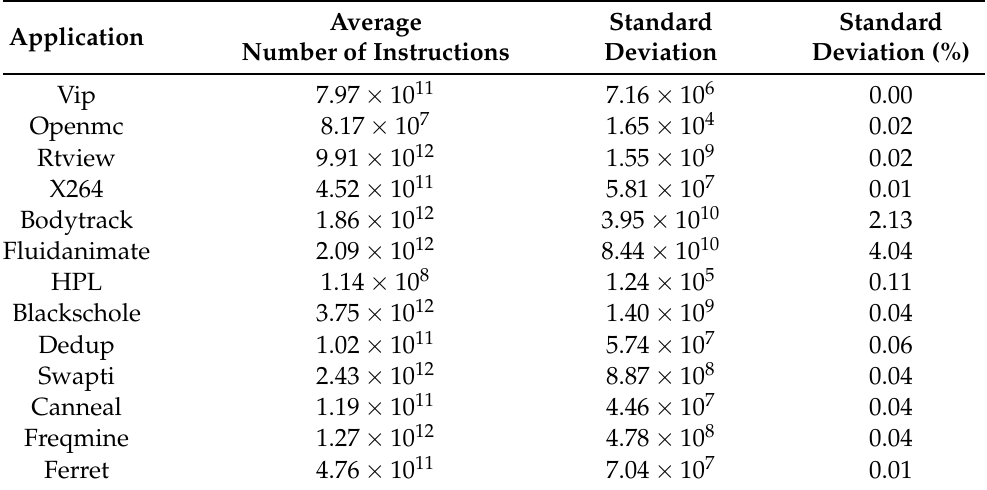
Table 3. Variation of the number of instructions when changing the number of cores for the same input.